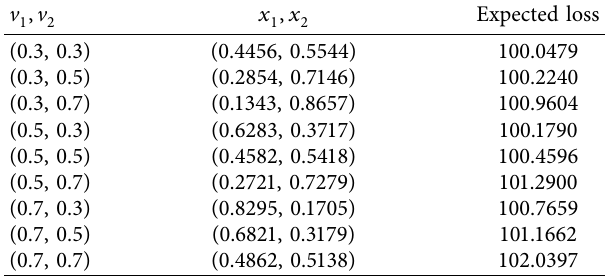
and v on the expected loss. 1 2